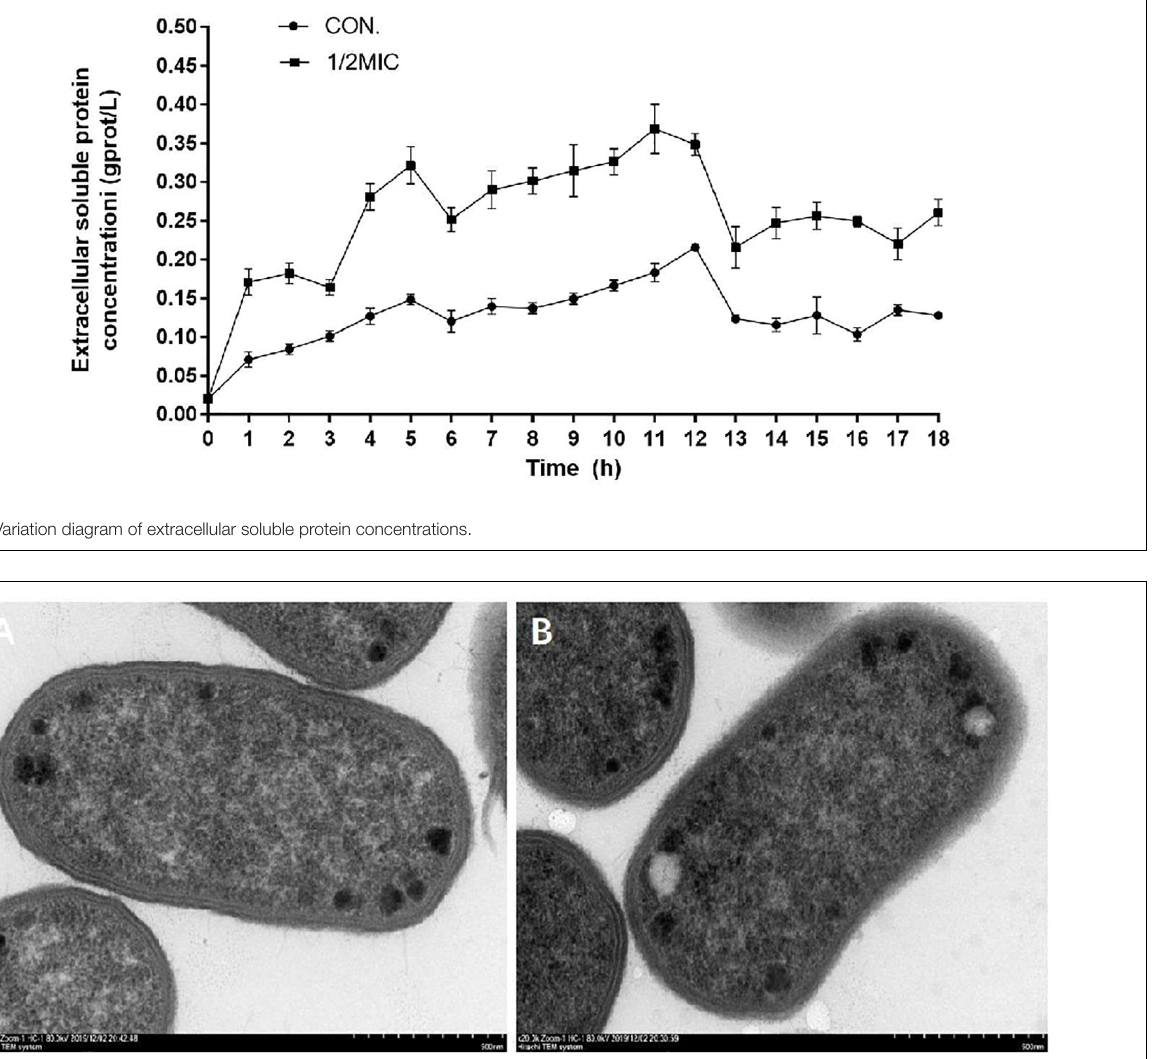
FIGURE 10 | Morphological changes after CPA treatment. (A) CON and (B) 1/2